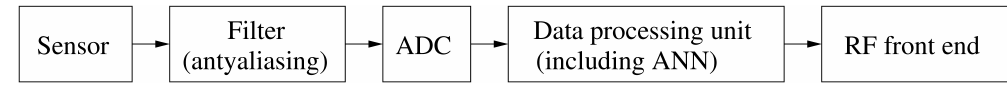
Figure 1. A general structure of the wireless intelligent